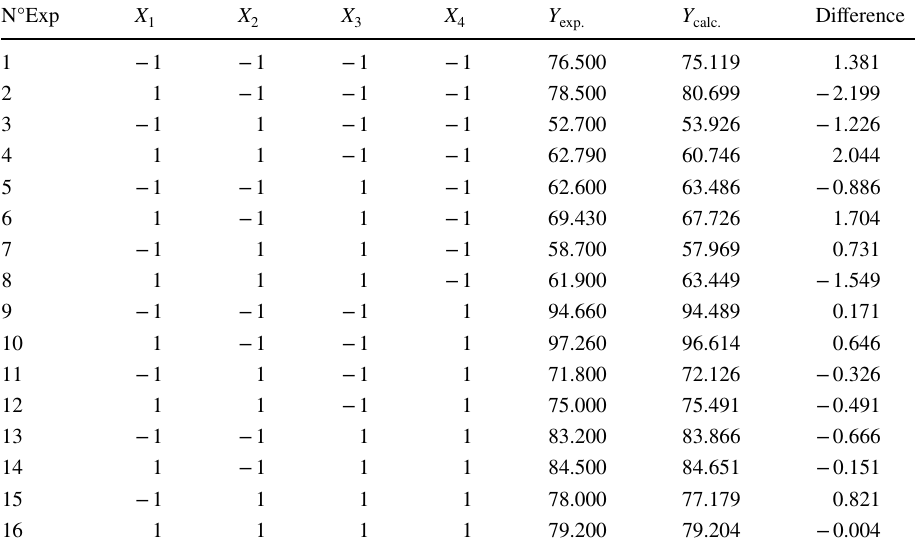
Table 3 Experimental design matrix and response based on the experimental runs and predicted values on discoloration of